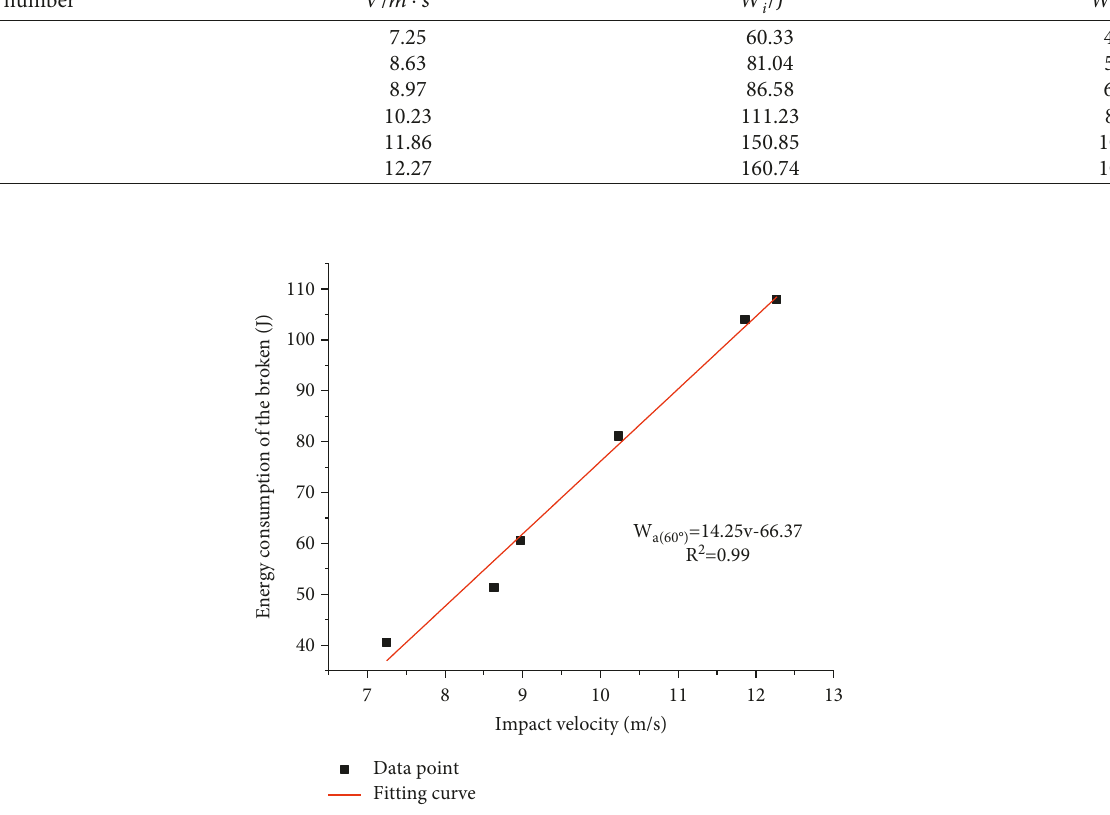
Figure 12: Fitting curve of crushing energy consumption-impact velocity of dynamic point load test at conical angle of 60 ° .